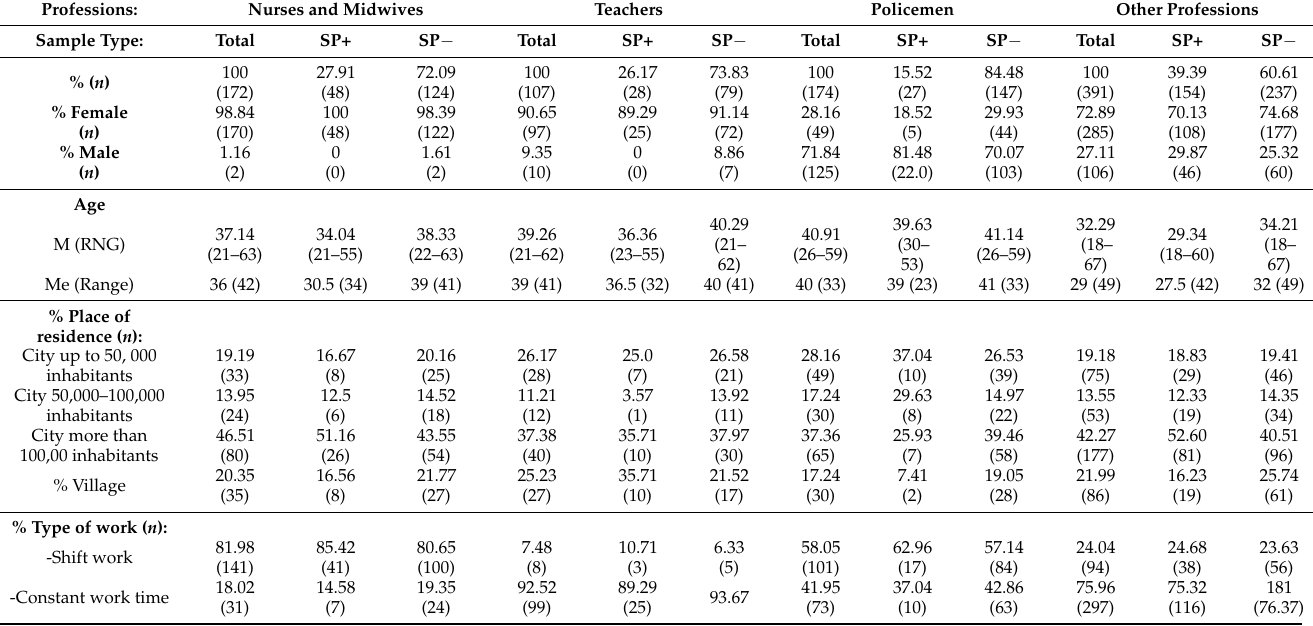
Table 1. Socio-demographic characteristics of participants, by profession group.